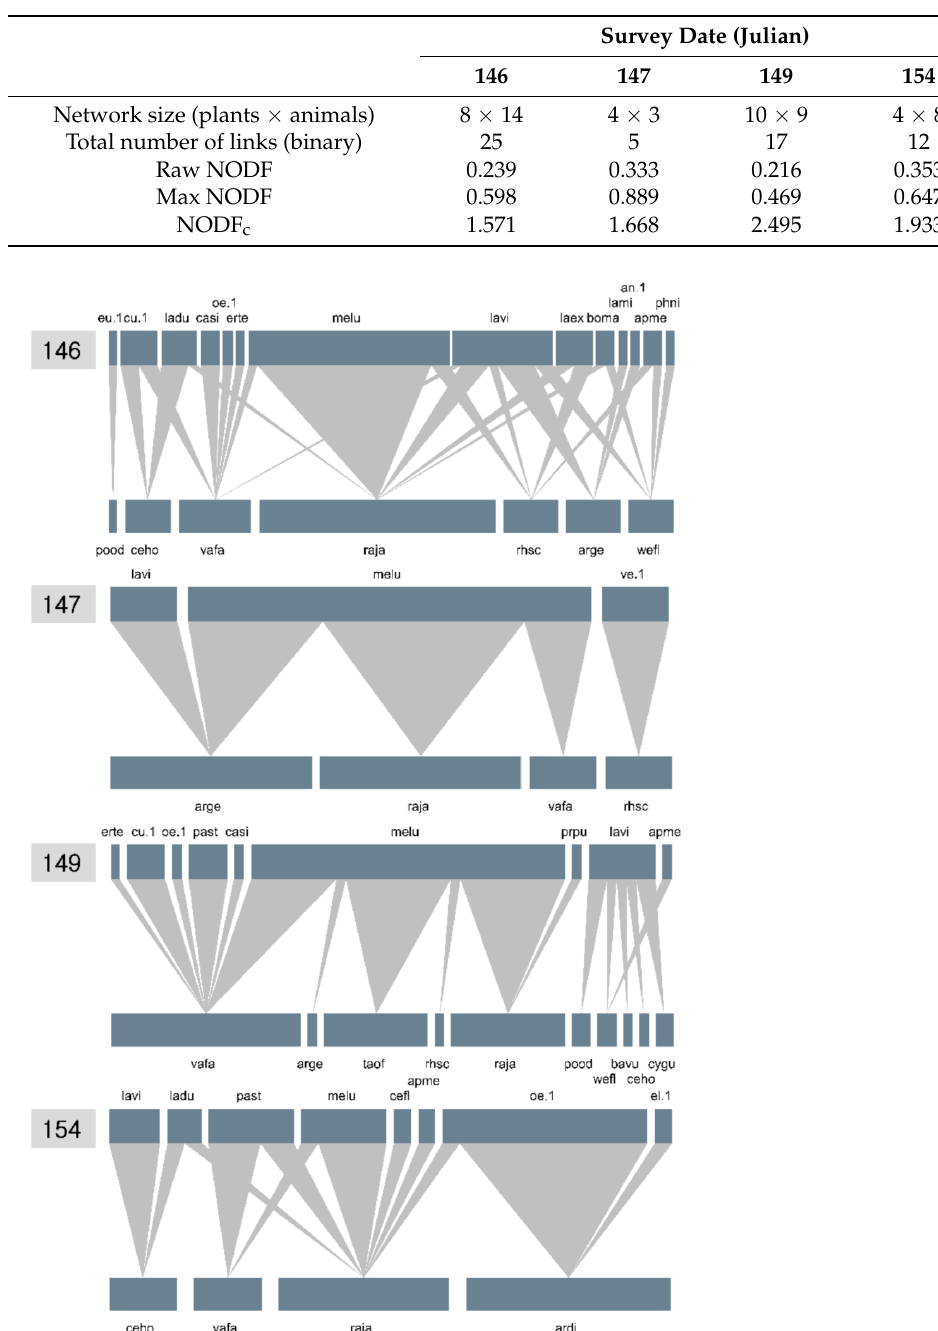
Table 6. Parameters and combined nestedness (NODF c ) of the daily networks. Raw NODF is the raw nestedness value, and max NODF is the maximum nestedness of a network with the same number of species and links as the focal network, which can be calculated only when every species has at least one link. The max NODF values for days 147, 149, and 154 were calculated by adding 3, 3, and 1 link(s) to their original matrices to satisfy the analysis requirement (i.e., the total number of plant and animal species ≤ number of links). In this case, the Max NODF will not be accurate, but the estimate is conservative.